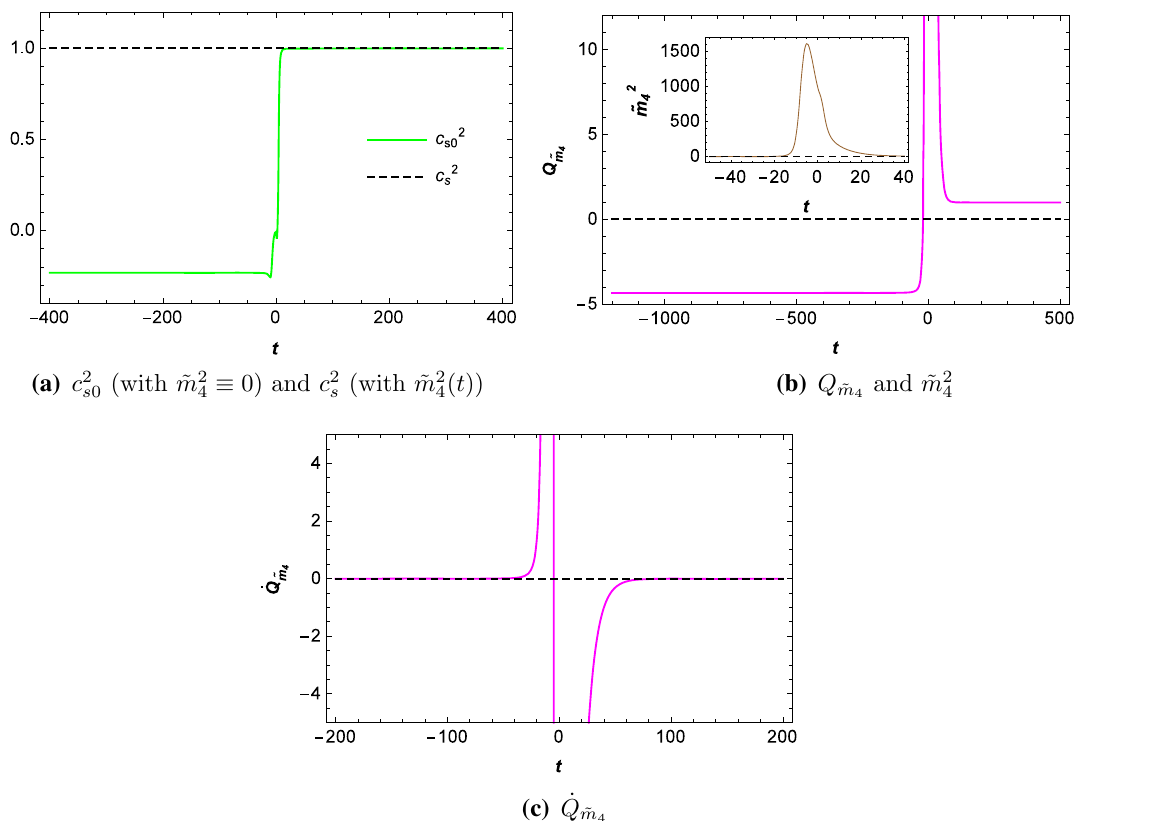
Fig. 4 The sound speed of the scalar perturbation with and without ˜ m 2